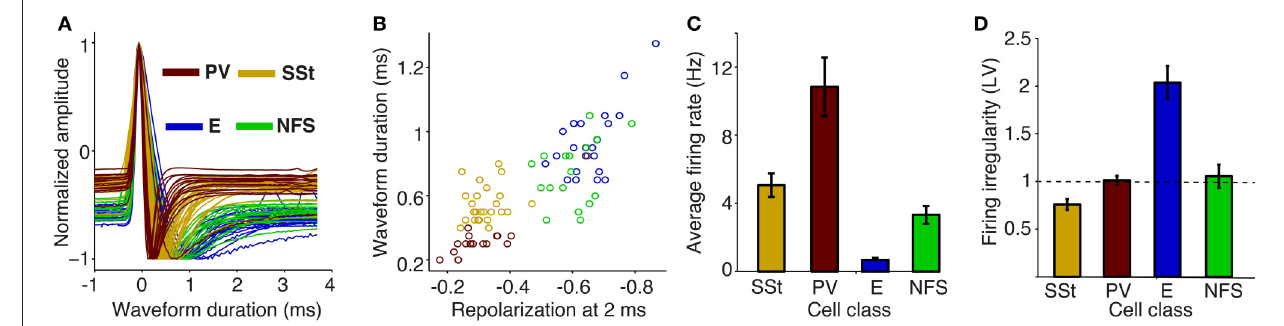
FIGURE 10 | Action potential waveform and firing rate properties for identified cellular phenotypes in mouse S1BF. (A) AP (Action Potential) waveforms were obtained by whole-cell whole-cell recordings from identified cellular phenotypes in awake mice. We took the 1st waveforms to allow for a comparison with extracellular waveforms. Shown is the normalized amplitude of the first derivative as a function of time (ms) relative to peak. SSt, Somatostatin-positive; PV, Parvalbumin-positive; E, excitatory; NFS, non-fast spiking. (B) Normalized first derivative amplitude at 2ms (repolarization) vs. peak-to-trough duration (ms). (C) Average firing rate (Hz) for different cell classes. (D) Mean ± SEM of firing irregularity (LV) for different cell